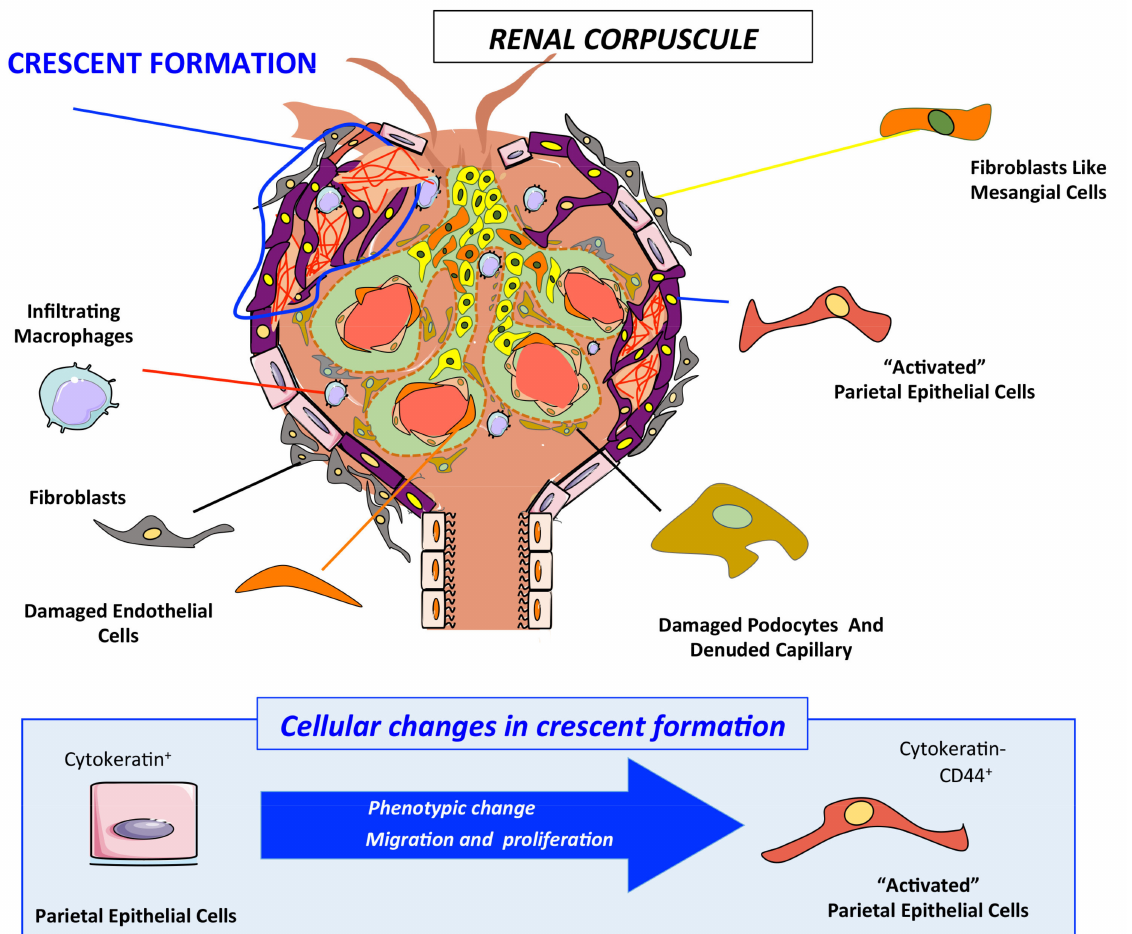
Figure 3. Glomerulonephritis characterized by a fibrous structure formation (crescent) in renal cor- puscle. Glomerular PECs (cytokeratin+) are the main actors, infiltrating cells such as macrophages (CD68+) in crescent formation during rapid progressive glomerulonephritis/crescentic glomeru- lonephritis (RPGN/CGN). Activated PECs (CD44+/cytokeratin-) invade the glomerular urinary space and obstruct the urinary space. PEC “activation” implies a phenotypic change that promotes their abnormal proliferation and their migration towards the urinary space of renal